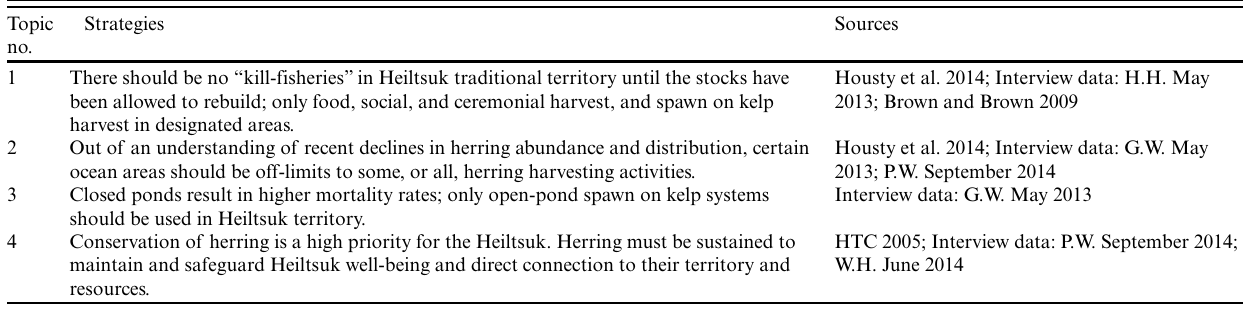
Table 4 . Recent management strategies for Pacific